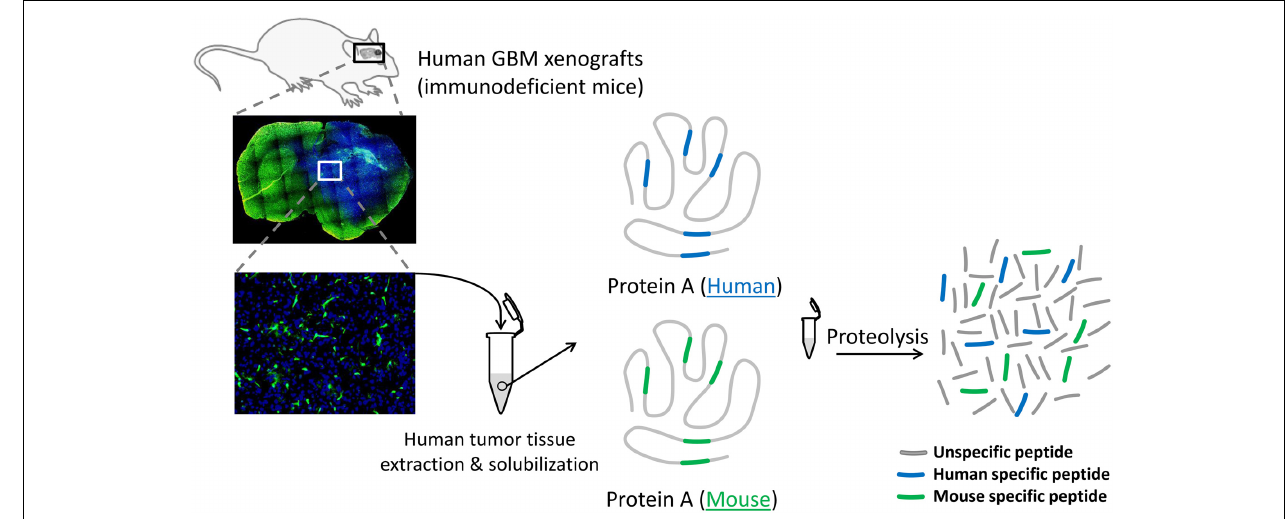
FIGURE 1 | Schematic of the protein extraction procedure from a human GBM xenografted in a GFP-expressing immunodeficient mouse. Since the excision of the human tumor tissue (in blue) includes a variable proportion of mouse cells (in green), the surrogate peptide selection process of a given